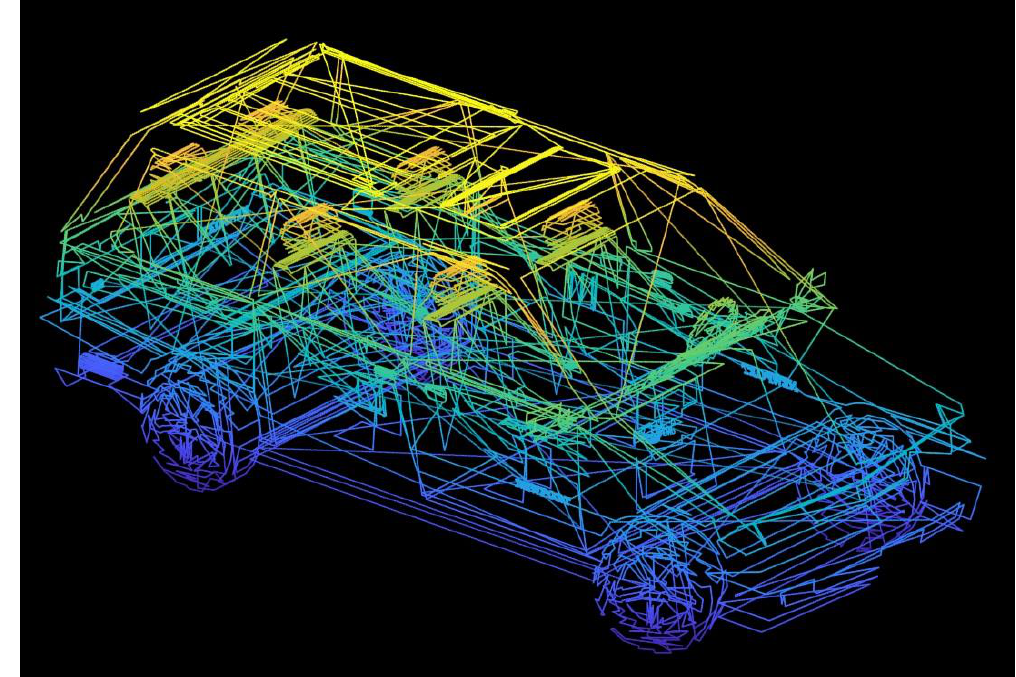
Figure 4. The interpolation Point Clouds.